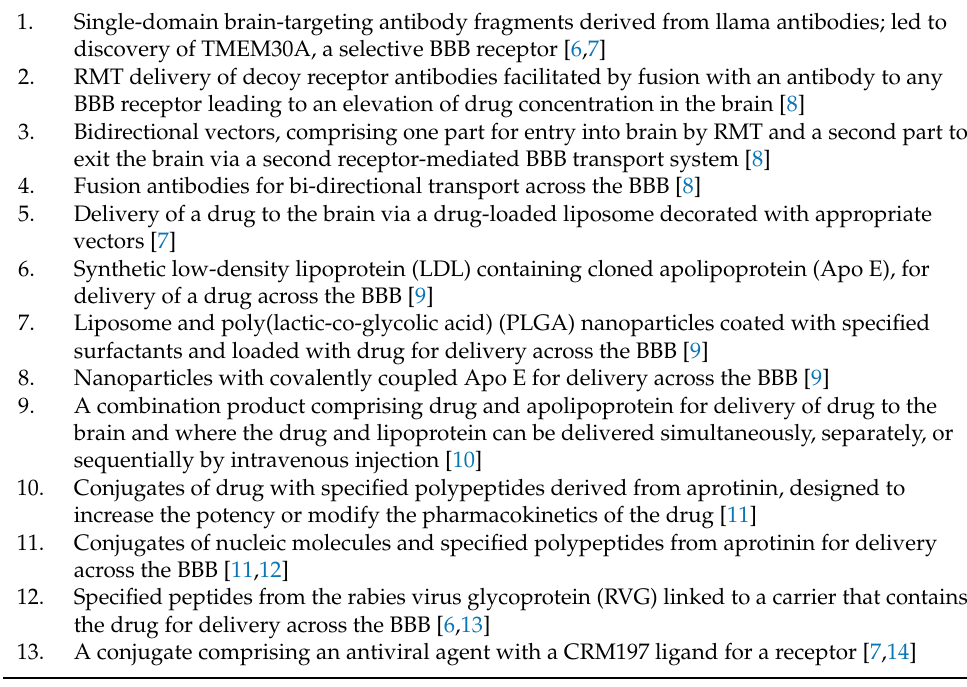
Table 1. Overview of large biomolecules in current preclinical development for enhanced delivery across the BBB. Part of this table is reproduced from Tucker (2011) with permission of the copyright owner [1]. Key Classes and Functions of